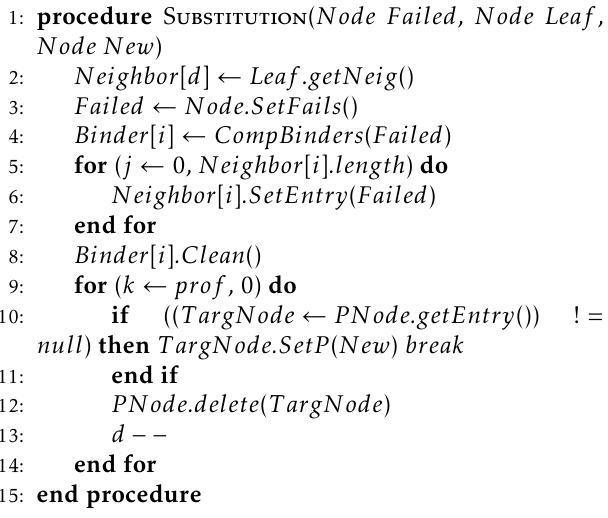
Algorithm 5 Substitution Algorithm of Failed